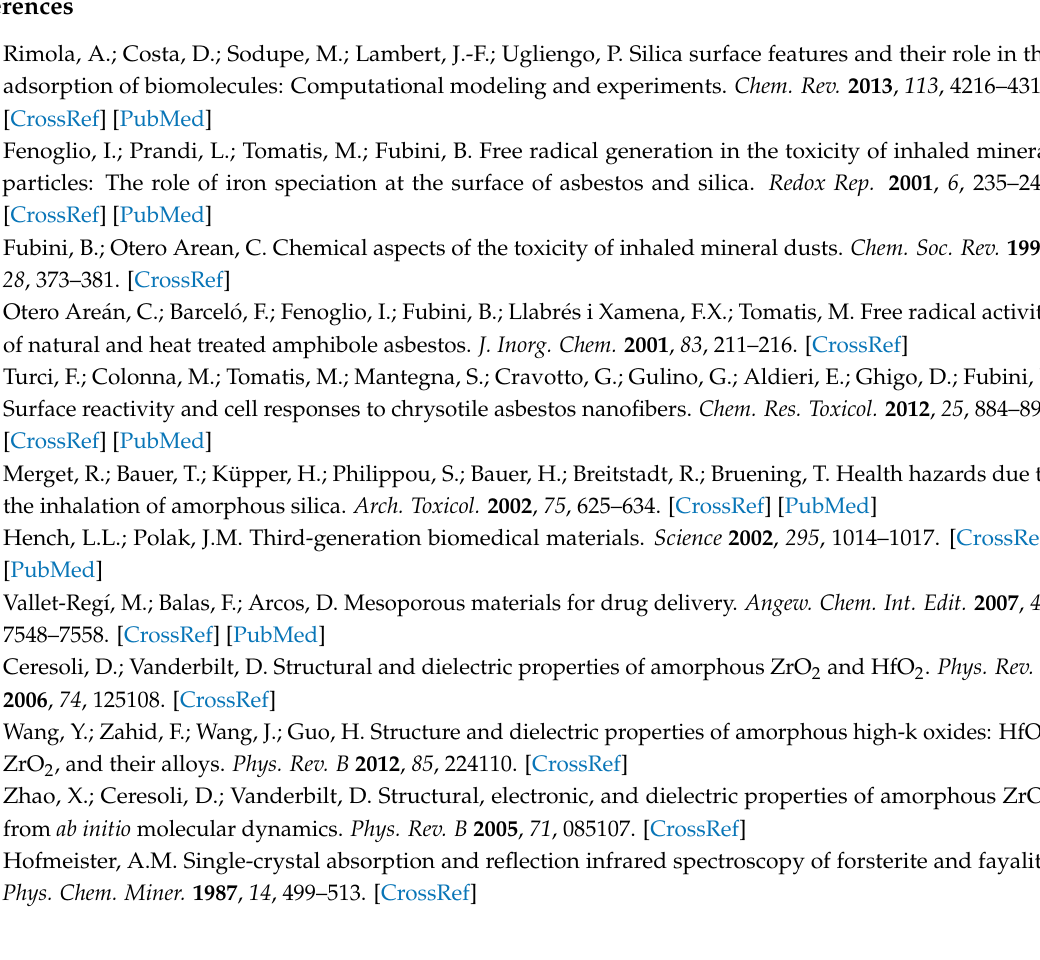
Figure S1: GULP-optimized structure for the bulk of the crystal Mg 2 SiO 4 . View of the unit cell (left), view of the extended periodic system (right), Figure S2: Mg–Mg (a) and Mg–O (b) pair correlation functions derived from the MD simulations at the different temperatures accounting for periodic boundary conditions, Figure S3: Mg–Mg (a) and Mg–O (b) pair correlation functions derived from the classical MD simulations for the 1 × 1 × 2, 2 × 1 × 2 and 2 × 2 × 2 systems, Table S1: Bond distance ranges (in Å) of the crystalline 1 × 1 × 1 Mg 2 SiO 4 bulk structures: experimental, GULP-optimized, and B3LYP and B3LYP-D2 optimized values, Table S2: Bond distance ranges (in Å) and lattice parameters (distances in Å, angles in degrees) of the amorphous 1 × 1 × 2 Mg 2 SiO 4 bulk structure optimized at B3LYP and B3LYP-D2 theory level, Scheme S1: Cell parameters and fractionary coordinates of the optimized